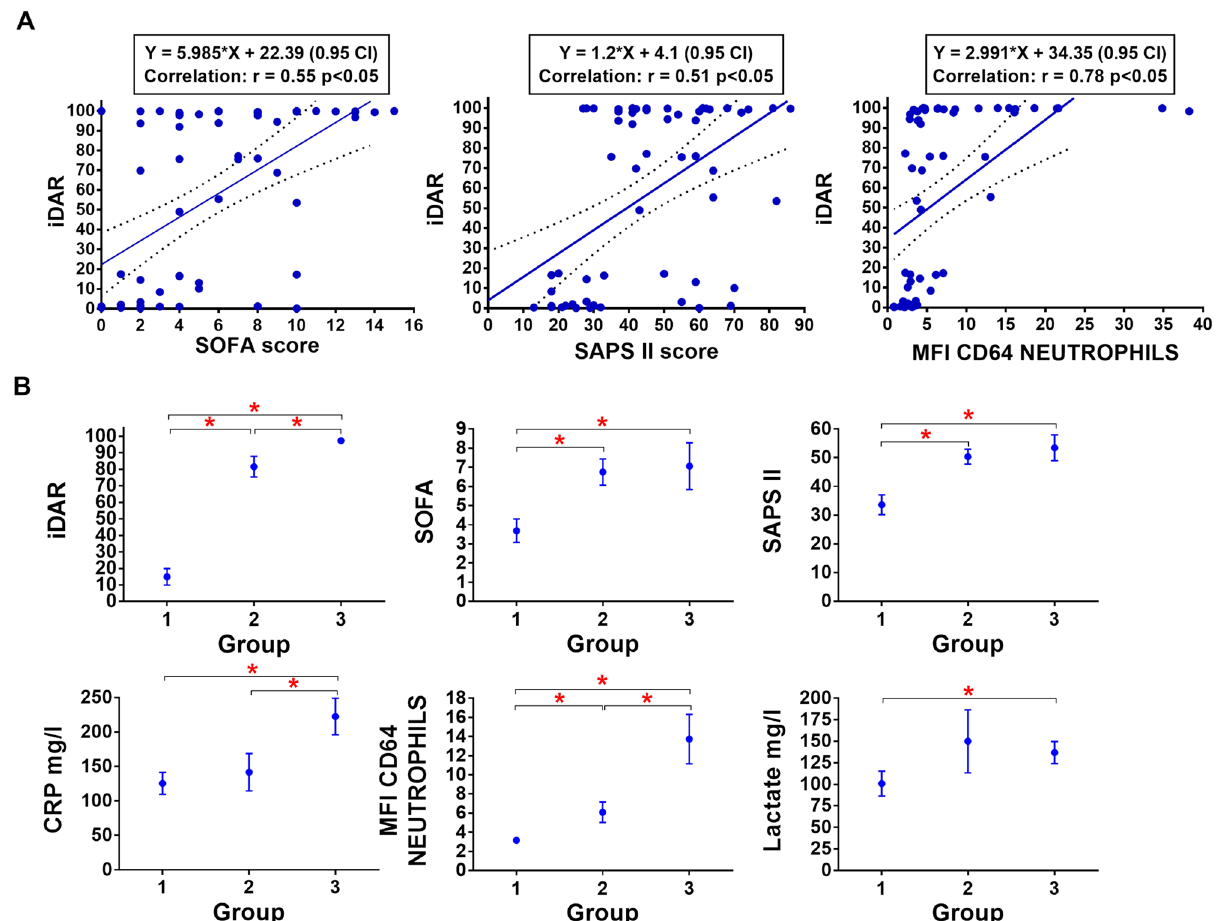
Figure 5. ( A ) Correlation between iDAR and SOFA, SAPS II or CD64 MFI ( B ). iDAR, SOFA, SAPS II, CRP, CD64 MFI and lactate levels in the validation cohort (mean ± SEM): Group 1, patients with no documented infection; Group 2, patients with a documented localized infection; Group 3, patients with systemic infection. * p < CD91 expression in that cell population was also decreased in BSI patients (Fig. 4K). Integrin β7 expression was initially decreased at 2 and 24 h after cardiac surgery and returned to control levels at 48 h but was not signifi- cantly modified during BSI (Fig. 4L).